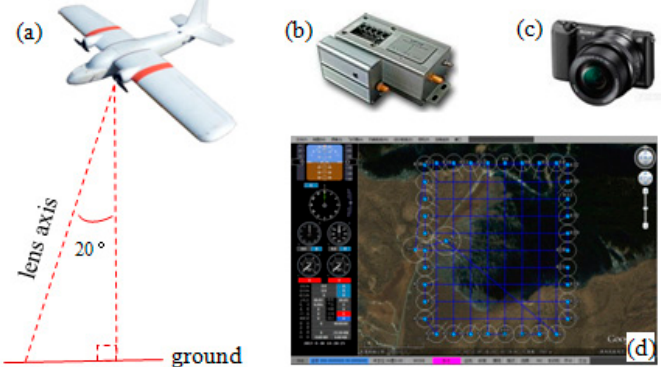
Figure 2. The Unmanned Aerial Vehicle (UAV) system and its major components: ( a ) fixed-wing UAV platform; ( b ) flight control system; ( c ) digital camera; and ( d ) ground station system.